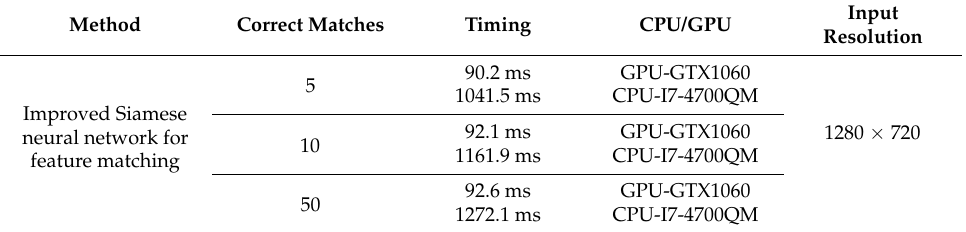
Table 1. Performance of timing for Level 2